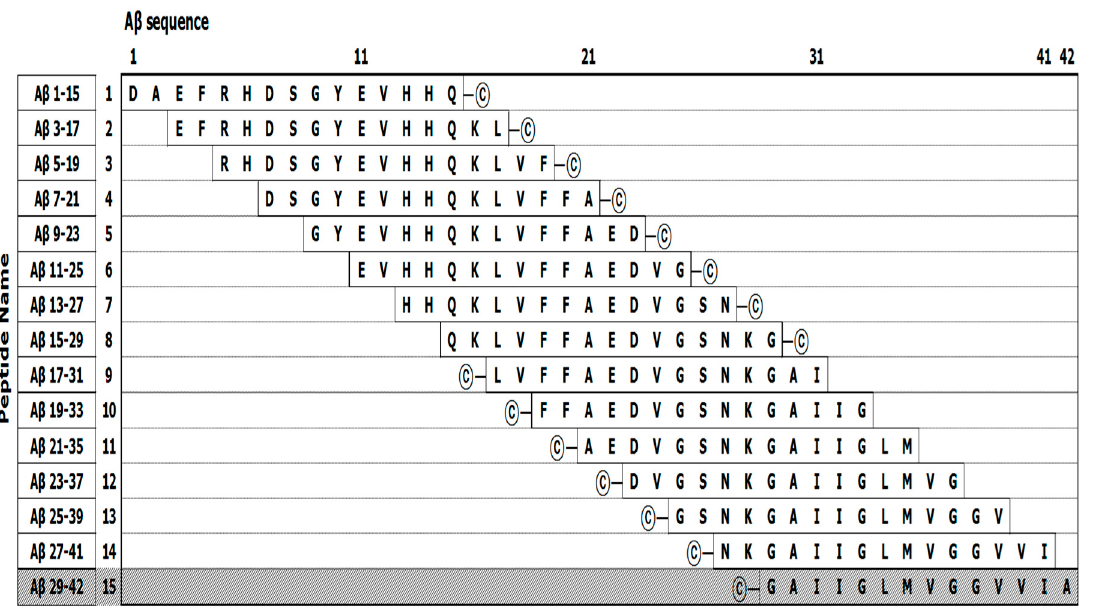
Figure 5. Schematic figures of A β 1–42 (extracellular β -amyloid 1–42) overlapping peptides. Each fragment was assigned an ID number, and © indicates the cysteine residue used for peptide conjugation.